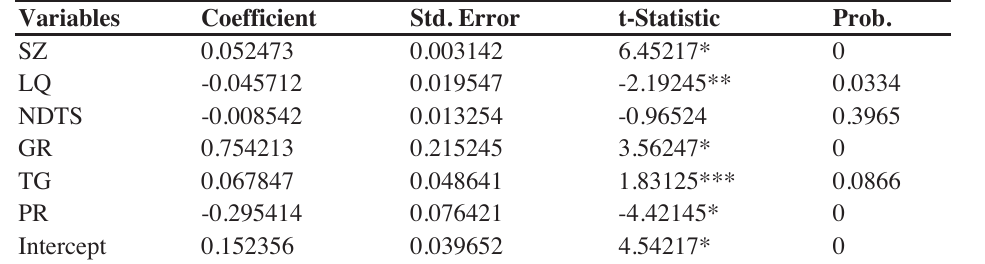
Result of Regression Output (Entire